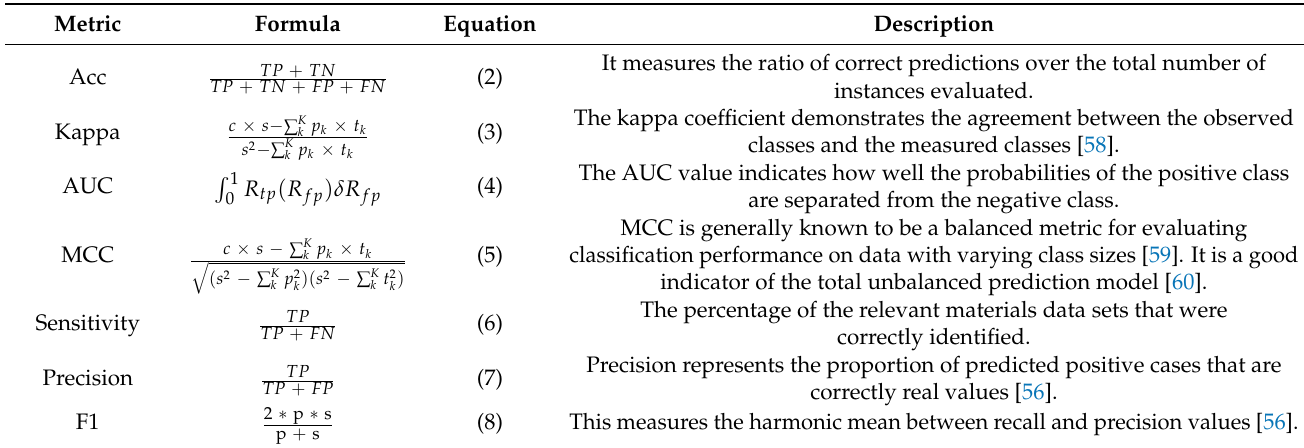
Table 3. Evaluation metrics with formula and description.